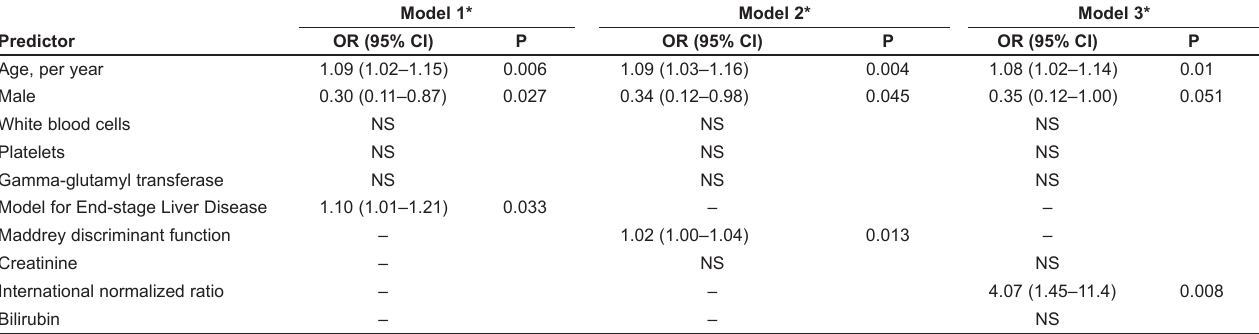
TABLE 2 Independent predictors of 90-day mortality in patients hospitalized for alcoholic hepatitis